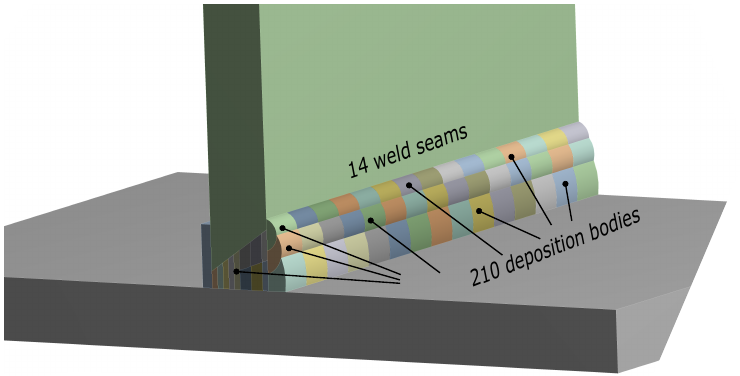
Figure 2. Prepared CAD geometry. Welding seams are modeled and split into different deposi- tion